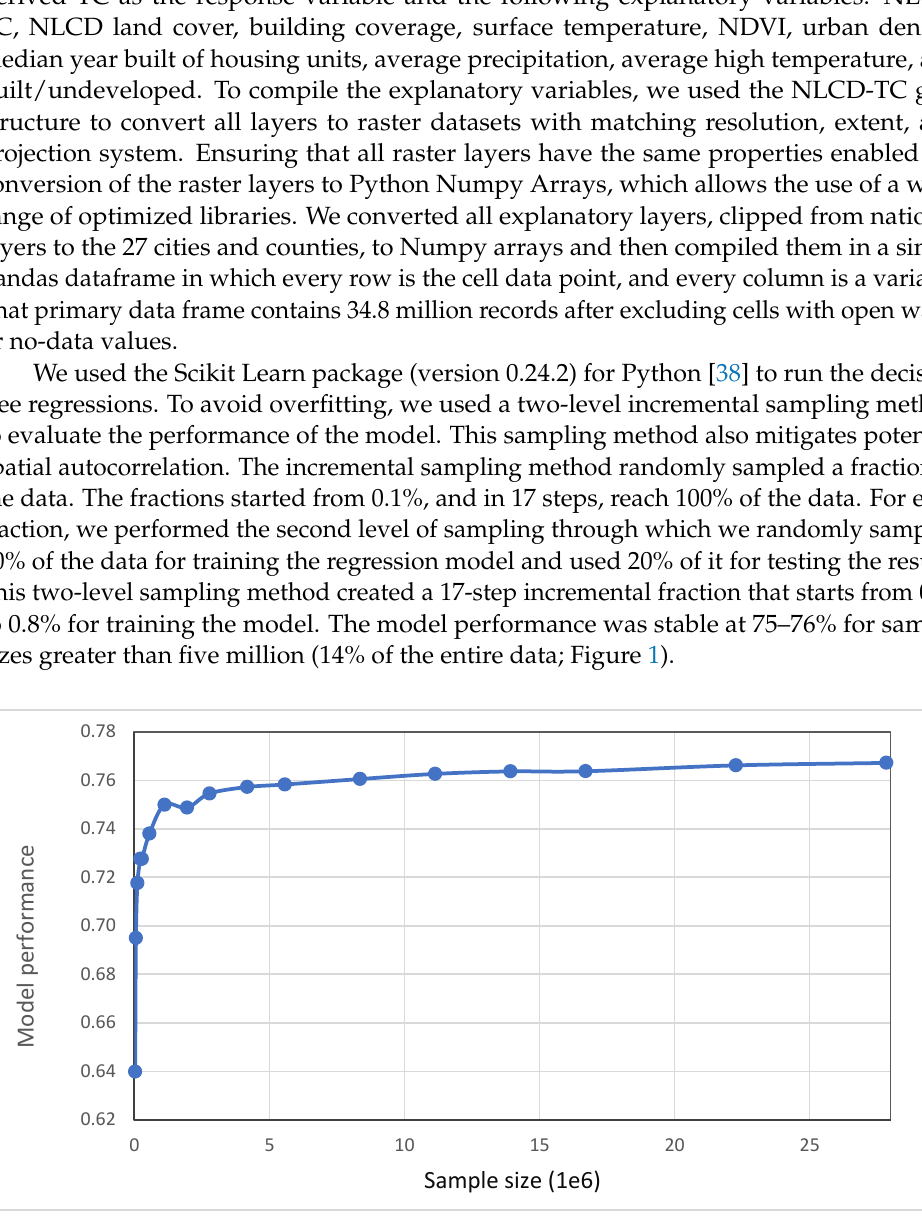
Figure 1. Model performance for incremental sample sizes (sample of cells drawn for running the predictive model).